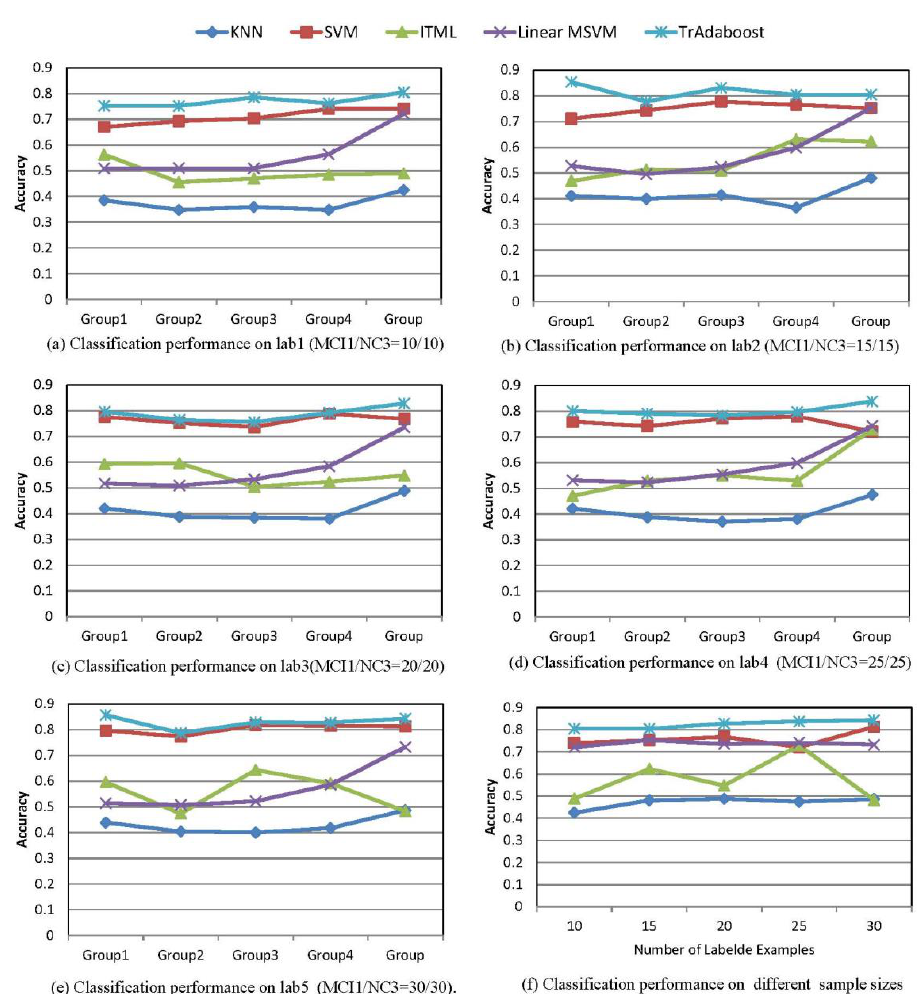
Figure 6. Comparison